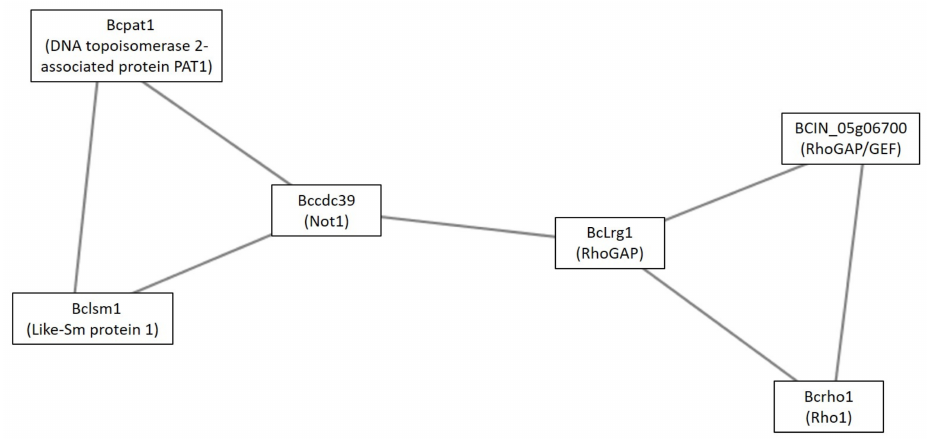
Figure 6. Cluster 36: signaling cluster under GLU condition. Clusters were obtained analyzing STRING networks of protein exclusively identified or overexpressed in B. cinerea proteomes (mem- branome, phosphoproteome, phosphomembranome, and secretome) under GLU with MCODE.